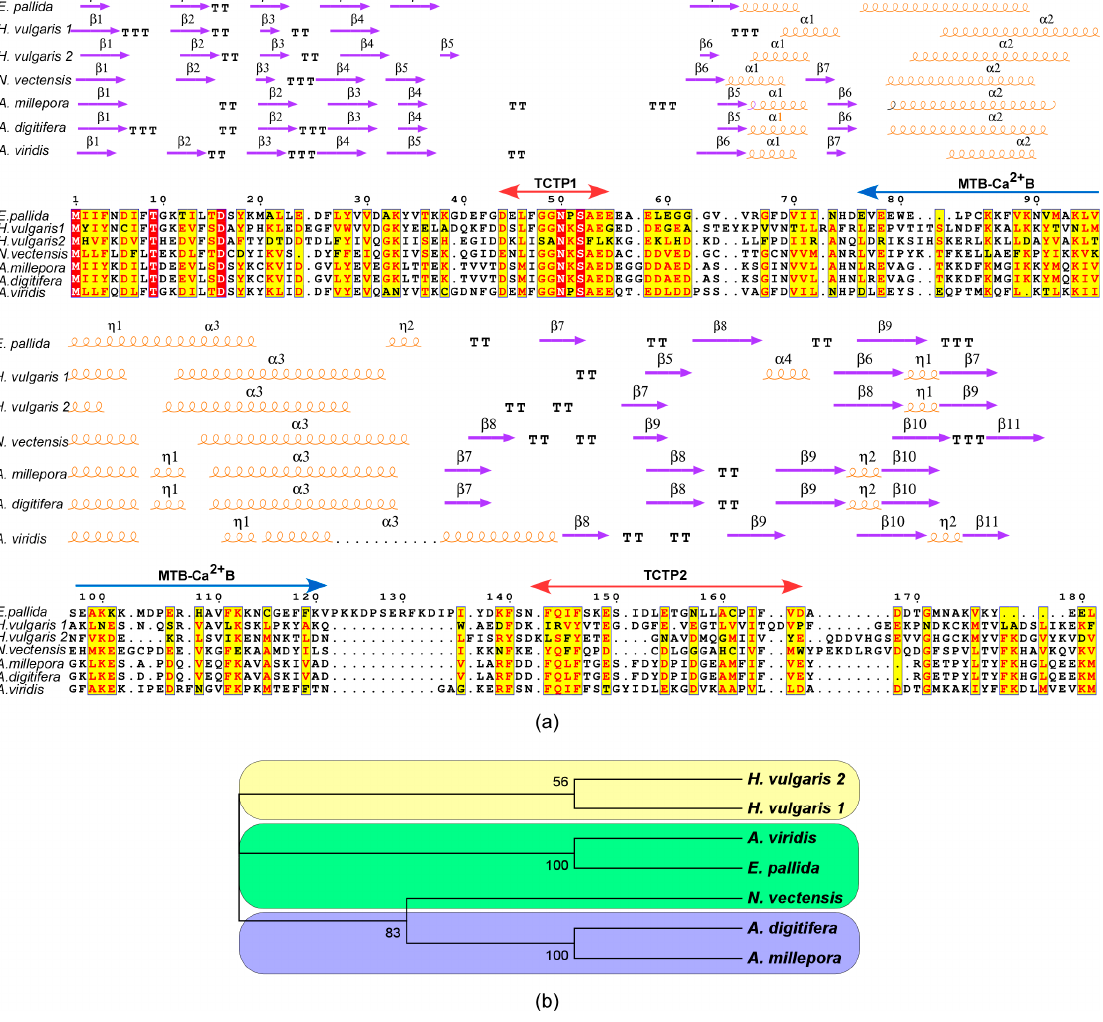
Figure 3. Phylogenetic relationship of Cnidarian TCTPs. ( a ) Multiple sequence alignment of the TCTPs in cnidarians. Alignment was performed with T-coffee. Similar residues are written in red bold characters and boxed in yellow whereas conserved residues are in white bold characters and boxed in red. The sequence numbering on the top refers to the alignment. ( b ) Phylogenetic tree based on the cnidarian TCTPs. The evolutionary history was inferred by using the Maximum Likelihood method based on the Poisson correction model. Internal branches were assessed using 1000 bootstrap replications. Branches corresponding to partitions reproduced in less than 50% bootstrap replicates are collapsed. The percentage of replicate trees in which the associated taxa clustered together in the bootstrap test are shown next to the branches.